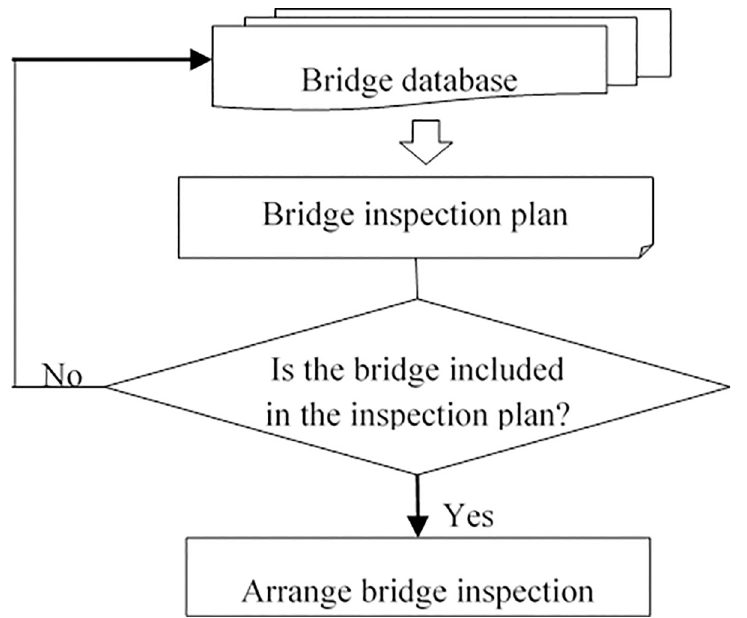
Fig 3. Current highway bridge inspection scheduling